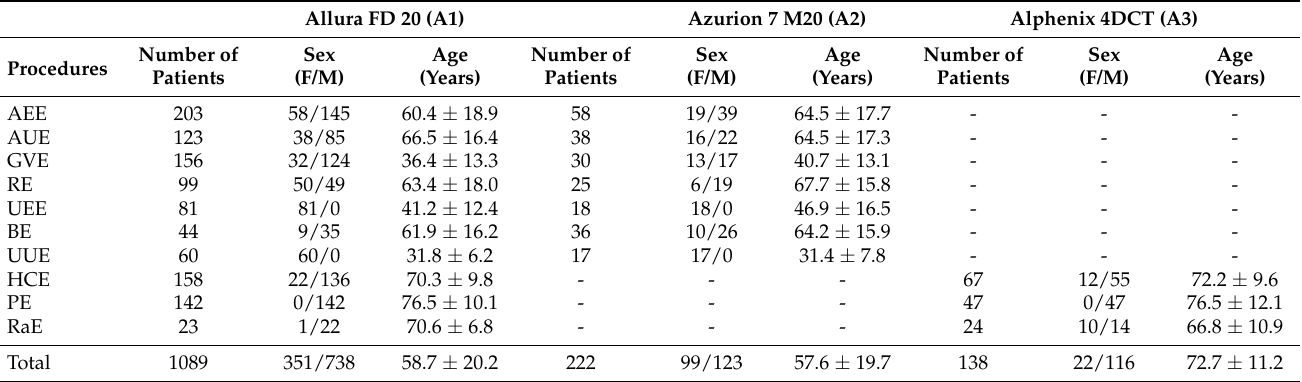
Table 1. Patients’